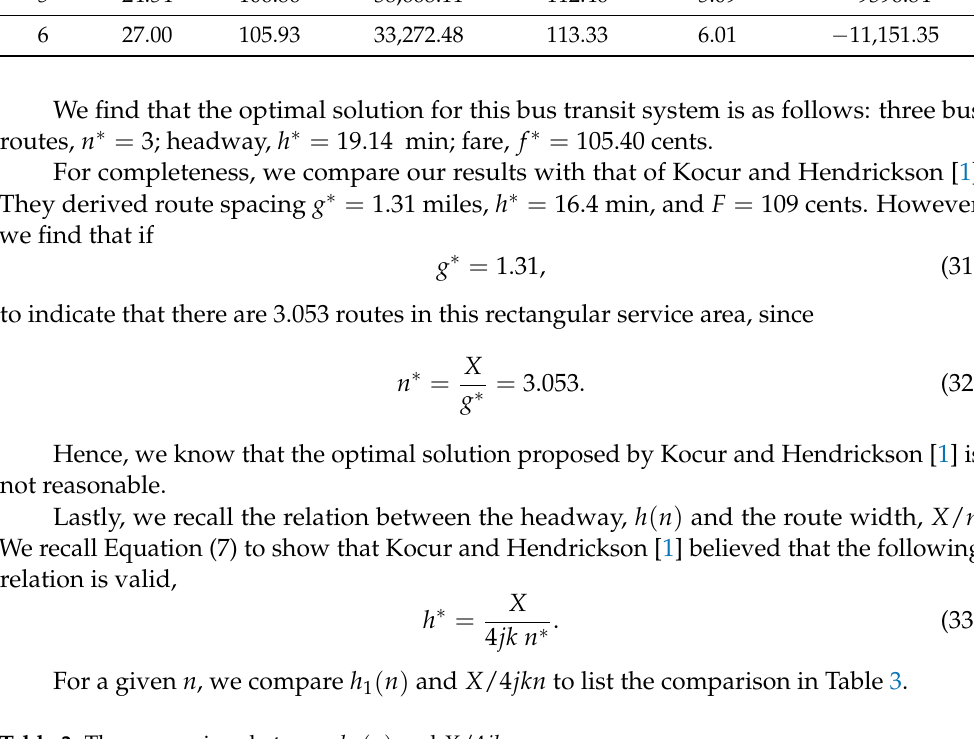
Table 3. The comparison between h 1 ( n ) and X /4 jkn